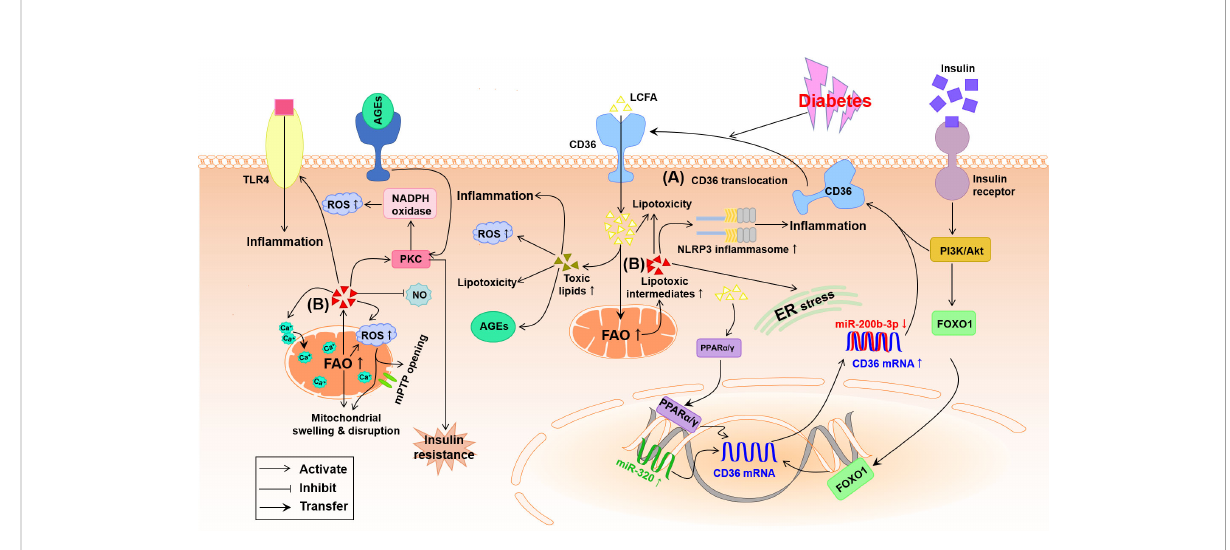
FIGURE 3 Potential pathways by which lipid metabolism disorder damages the diabetic heart. (A) Under diabetes conditions, the expression of cardiac PPAR a / g and FOXO1 is increased meanwhile miR-200b-3p is decreased and miR-320 is increased, which helps to up-regulation of CD36 causing the increase in LCFA uptake. (B) Abnormal FAO and accumulation of lipotoxic intermediates in the diabetic cardiomyocyte trigger oxidative stress, in fl ammation and ER stress. Furthermore, accumulation of lipotoxic intermediates in the diabetic cardiomyocyte increases mitochondrial uncoupling and impairment of mitochondria Ca 2+ handing, leading to mitochondrial swelling and disruption through the opening of mitochondrial permeability transition pore (mPTP). AGEs, advanced glycation end-products; Akt, protein kinase B; CD36, cluster of differentiation 36; ER, endoplasmic reticulum; FAO, fatty acid oxidation; FOXO1, forkhead box protein O1; LCFA, long-chain fatty acid; NLRP3, nucleotide-binding domain, leucine-rich-containing family, pyrin domain containing 3; NO, nitric oxide; PI3K, phosphoinositide 3-kinase; PKC, protein kinase C; PPAR a / g , peroxisome proliferator-activated receptor a / g ; ROS, reactive oxygen species; TLR4, toll-like receptor